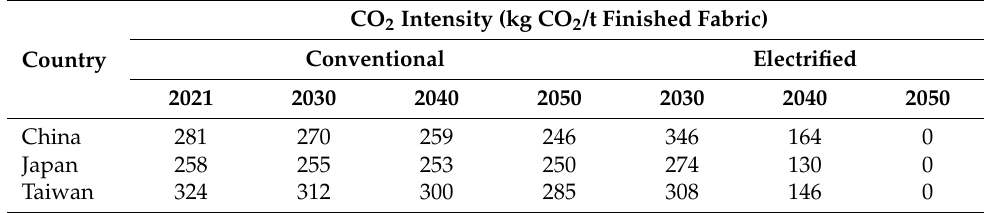
Table 13. The CO 2 intensity of the conventional and electrified heat setting process (Stenter machine). CO 2 Intensity (kg CO 2 /t Finished Fabric) Conventional Electrified Country